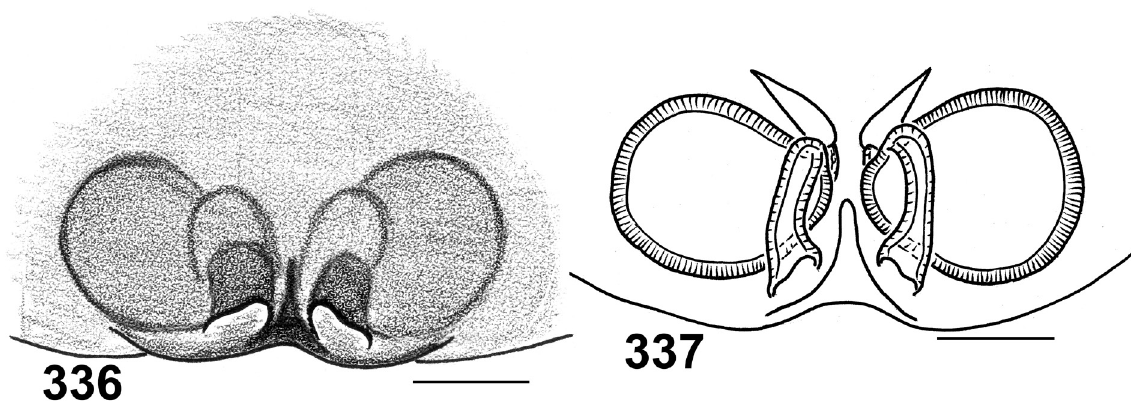
Figs 336–337. Stenaelurillus lesserti Reimoser, 1934, ♀ from Sri Lanka ( Pollonaruwa). 336 . Epigyne, ventral view. 337 . Spermathecae, dorsal view. Scale bars: